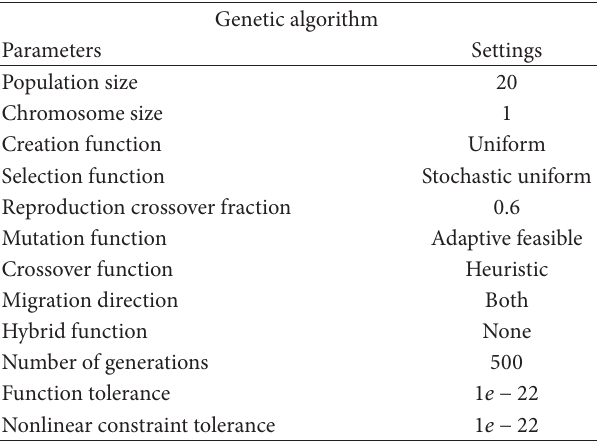
Table 1: Parameter settings of GA.